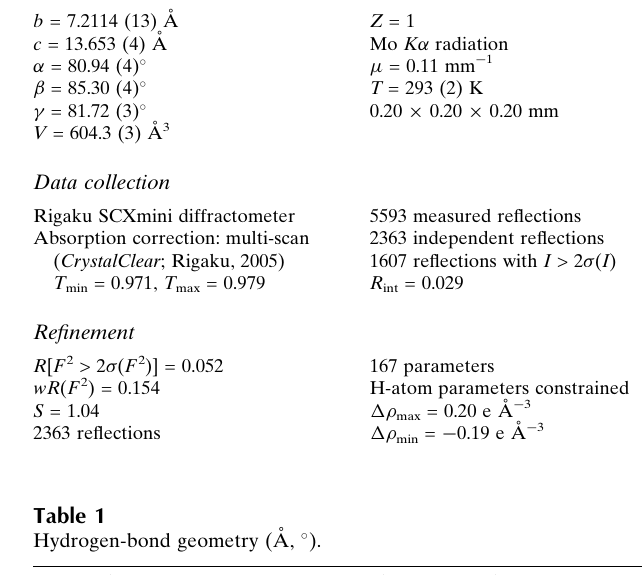
Hydrogen-bond geometry (A˚ , (cid:2) ). D —H (cid:1)(cid:1)(cid:1)